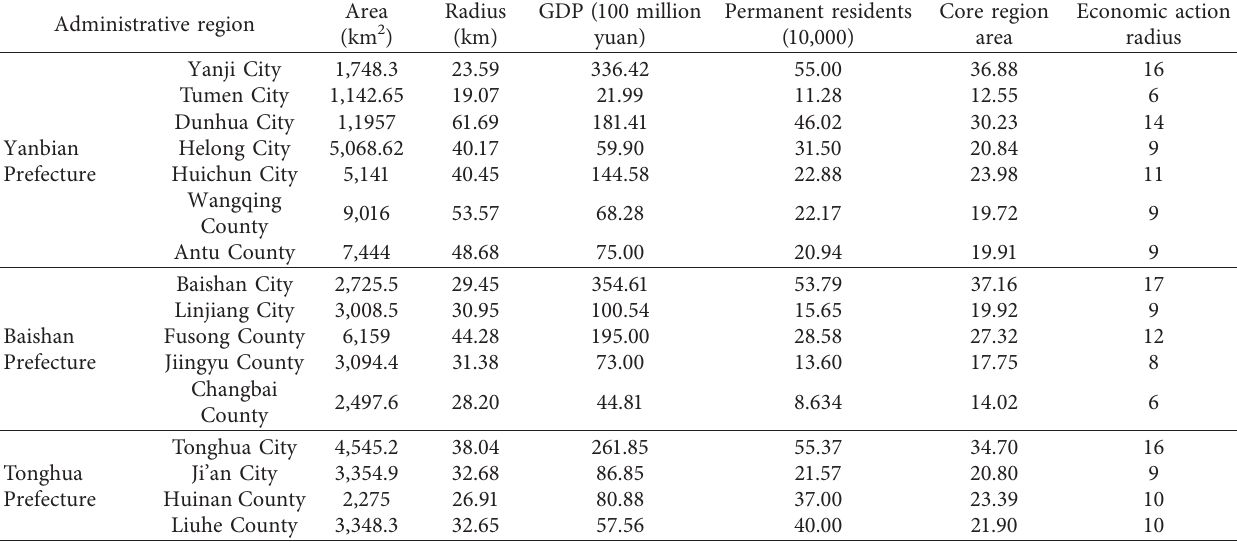
Table 3: Symbiosis densities of counties/cities in the core region of GCM tourist